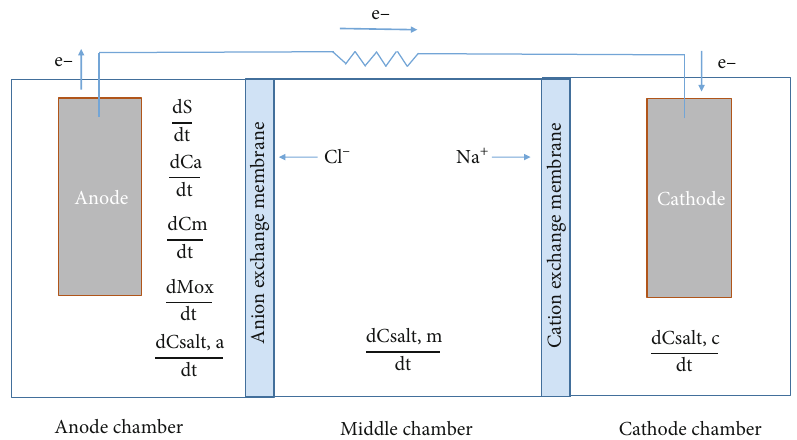
Figure 1: Conceptual schematic of an MDC, including a description of the changes in the main parameters. Table 1: Model parameters values based on previous work. Parameter Value Dimensions